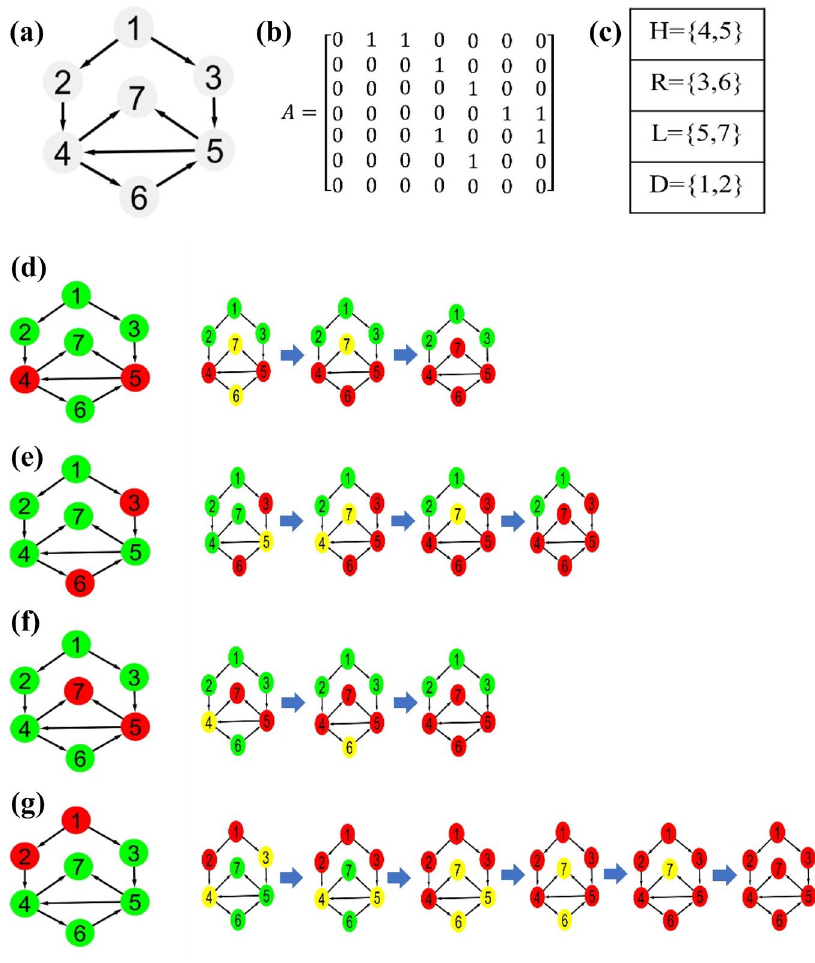
Figure 1. The effect of an initial choice of free-rider nodes on strategy switching by the other network nodes. ( a ) A directed network with 7 nodes and 9 edges. ( b ) The Network adjacency matrix. ( c ) H: the nodes with the maximum out-degree, R: random selection of the initial target nodes, L: local selection of the nodes, D: the nodes with the highest control power in the network. ( d ) The selection of the hub nodes as the initial target for the free-rider nodes and an analysis of the changes in the strategies of the other nodes, where the final level of 3 (cid:31) 7 . (At each stage, the free-rider nodes are displayed in red, their immediate neighbors cooperation amounts to are displayed in yellow and their cooperating nodes are displayed in green). ( e ) The final level of cooperation 2 (cid:31) 7 . ( f ) By selecting the local nodes as the free- through a random selection of the free-rider nodes amounts to 3 (cid:31) 7 . ( g ) The selection of the nodes with the highest control power as riders, the final level of cooperation will be the free-riders results in a hierarchical strategy change in a network’s total nodes and as a result, the network’s complete